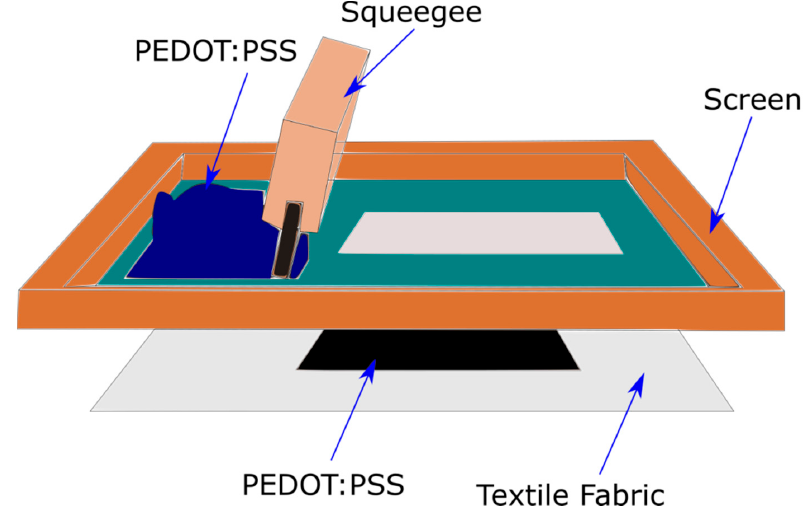
Figure 6. Schematic illustration of PEDOT:PSS screen printing on a textile fabric. Adopted from [91].